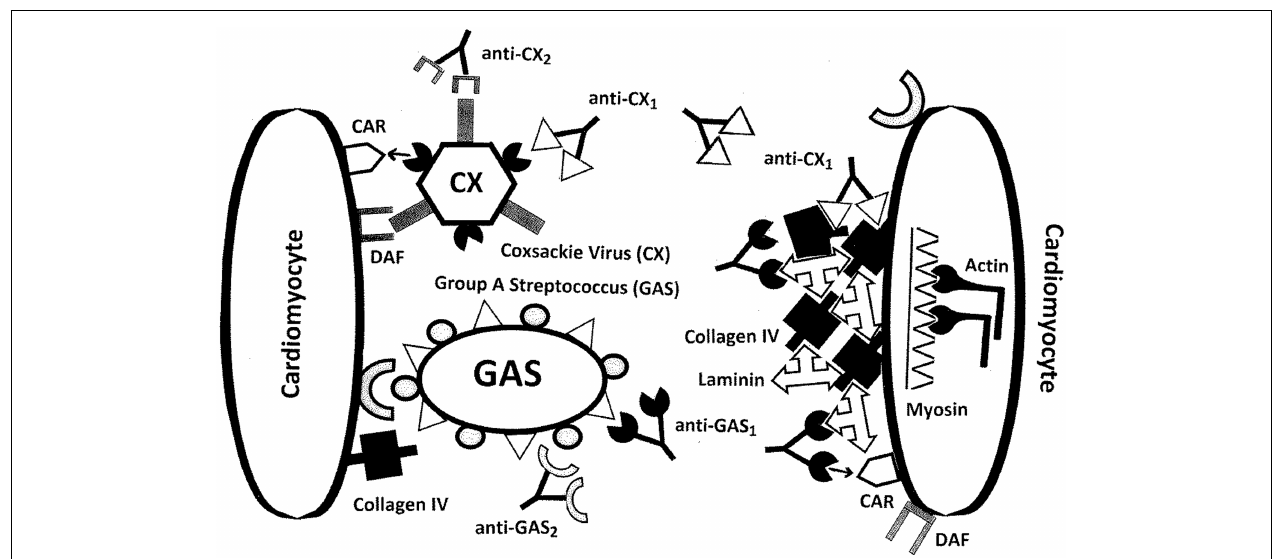
that anti-CX immune responses may also target collagen IV and B1AR. GAS uses collagen IV and various other cardiac proteins as receptors.The M protein of GAS mimics laminins so that antibodies against GAS may also target cardiac laminins. In addition, GAS M protein and laminins share epitope similarities with CAR, so that CAR may be an additional target of GAS antibodies. Note that although the illustration shows antibodies, the same sets of interactions could occur withT cell receptors